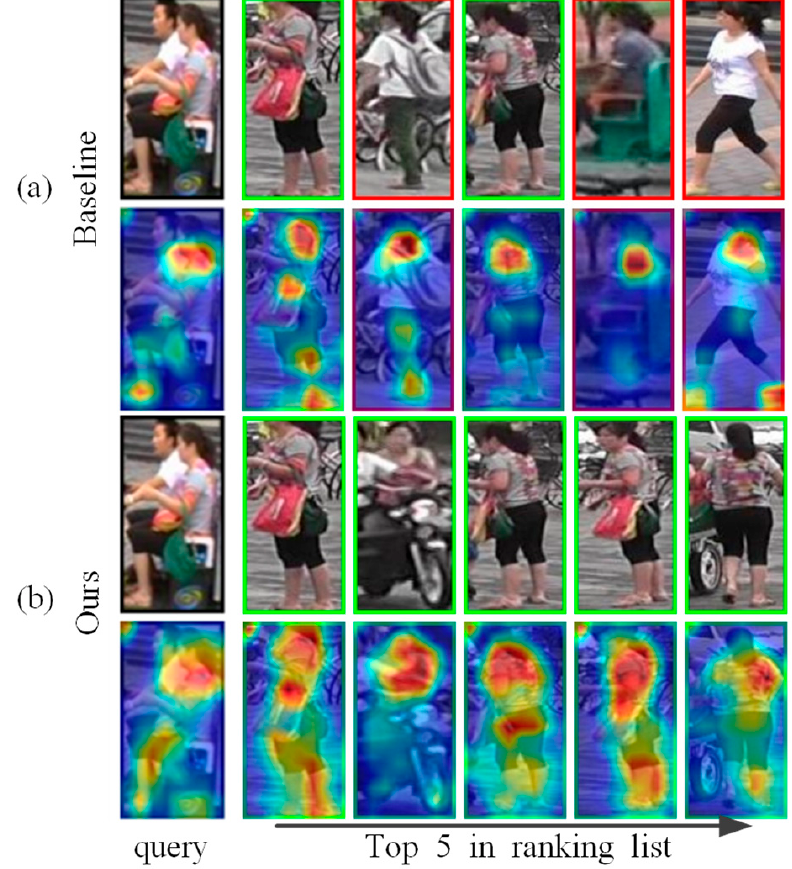
Figure 1. ( a , b ) represent the top 5 query results returned by the same query image through the baseline and the proposed method. The images with the green and red boxes are positive results and negative results. We also show the activation maps of each image; the second line shows that the baseline focuses on the person’s torso. The difference is that the proposed method discovers more visual cues from the whole body, as shown in the 4th line.